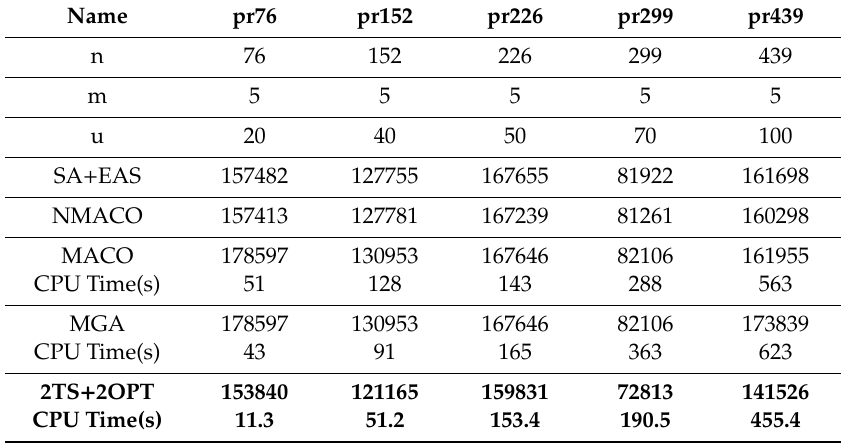
Table 1. The Comparison Result of 2TS + 2OPT Algorithm in the library of sample traveling salesman problem (TSPLIB)